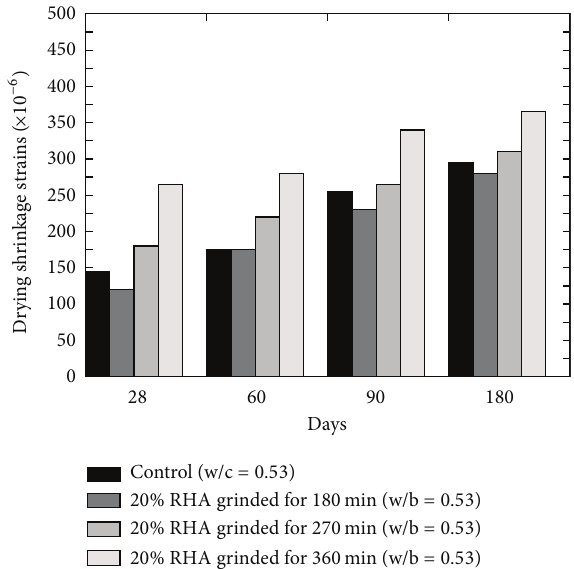
Figure 7: Effect of RHA fineness on the drying shrinkage of RHA concrete